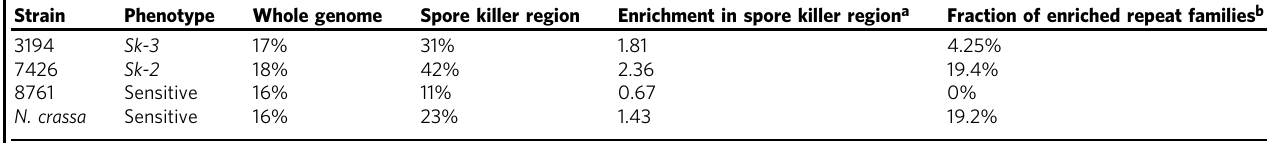
Table 2 Repetitive content in genomic regions of Sk-2 , Sk-3 , and sensitive strains of N. intermedia